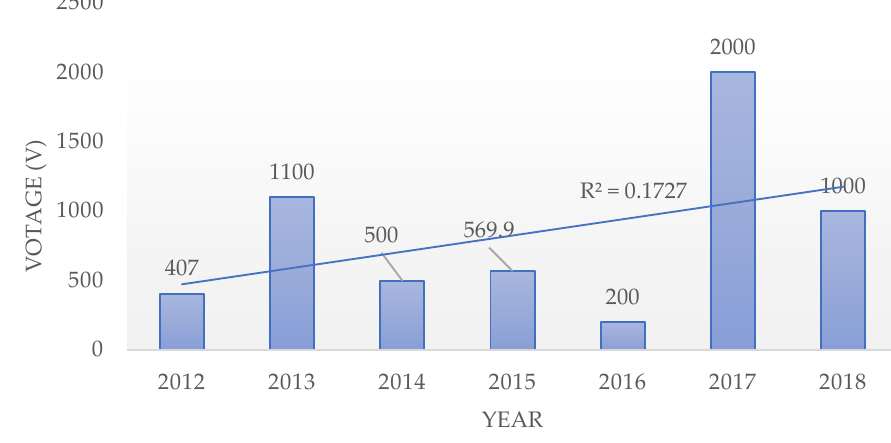
Figure 6. The maximum voltage obtained from TENG over the years.